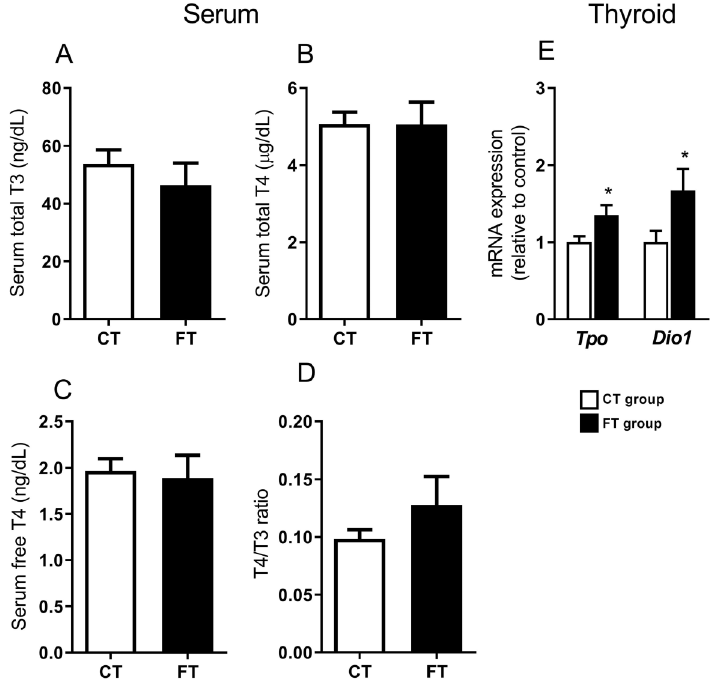
Figure 1. Serum concentrations of thyroid hormones and thyroid mRNA expression. A , Serum total T3. B , Serum total T4. C , Serum-free T4. D , T4/T3 ratio. E , Expression of thyroperoxidase ( Tpo ) and deiodinase type 1 ( Dio1 ) in the thyroid. The real-time PCR results are corrected by the reference gene Rplp0 and expressed relative to the values of the control group, which was set to 1. Control group (CT); Fructose group (FT - 10% fructose diluted in drinking water, for 3 weeks). Data are reported as means ± SE (6 – 8/group). *P o 0.05, Student ’ s t